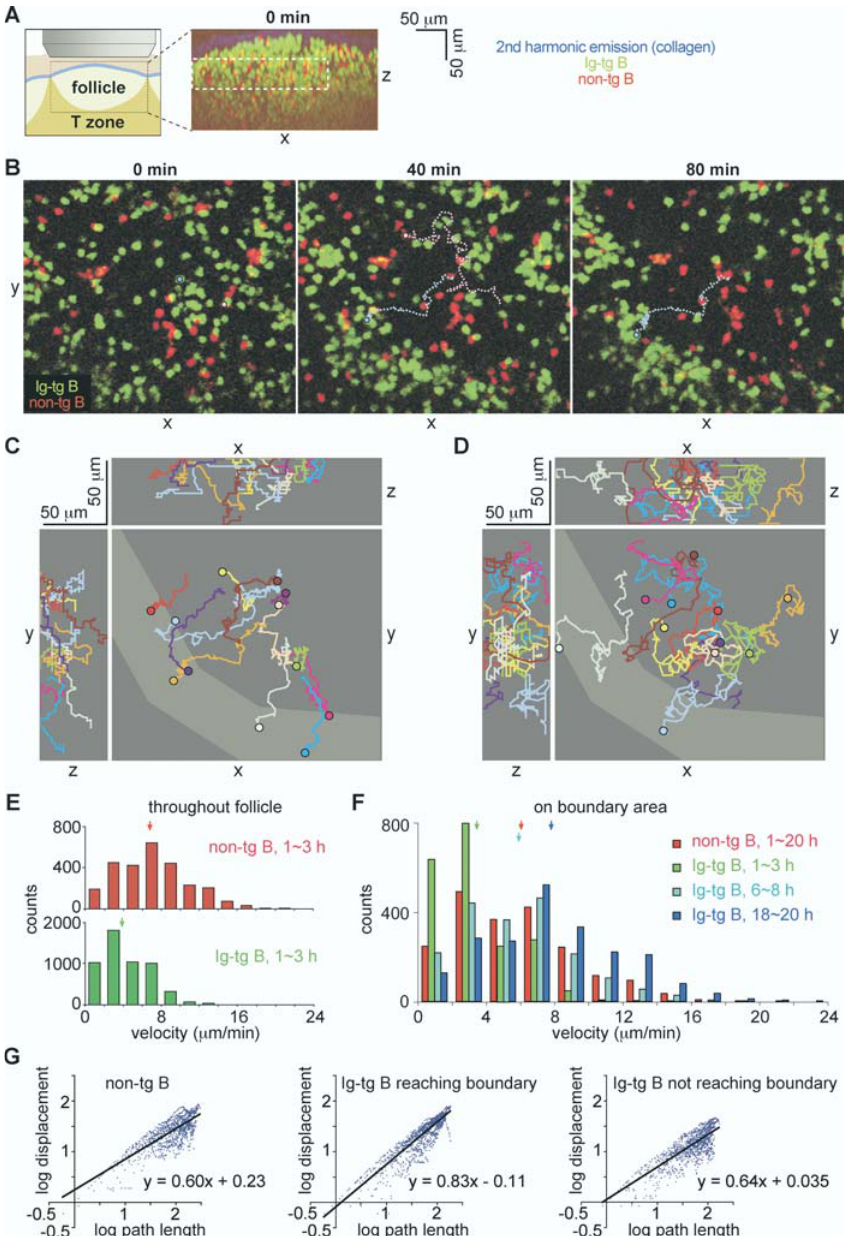
Figure 1. Antigen-Engaged B Cells Reduce Random Motility and Migrate Toward the Follicle–T Zone Boundary (A) On the left is a diagram showing the region of the inguinal lymph node that was imaged. The right panel shows the xz projection view of an image stack collected immediately prior to time-lapse imaging, demonstrating the location of a B cell follicle containing transferred B cells (green and red). The collagen-rich lymph node capsule is visualized by second harmonic emission (blue). The dashed white rectangle shows the region used in the time-lapse image analysis. (B) Time-lapse images of HEL-engaged Ig-tg B cells (green) clustering at the follicle–T zone boundary and naive non-tg B cells (red) in the follicle. The 0-min image is approximately 1 h after antigen exposure (see Video S1). The pathways of an Ig-tg B cell (light blue circle and dotted line) and a non-tg B cell (pink circle and dotted line) are traced as examples. The traced non-tg B cell moved out of the imaging stack at the 57.5-min timepoint. Scale as in (C). (C and D) Tracks of antigen-engaged Ig-tg (C) and naive non-tg (D) B cells in the xy-, xz-, and yz -planes. The boundary as defined by the area of Ig- tg B cell accumulation at 120 min is shown in lighter gray. Tracks cover 30 to 112 min (C) and 30 to 57 min (D). Circles indicate the end point of tracking. (E) Velocity distribution for naive (upper histogram) and antigen-engaged (lower histogram) B cells. Data are shown for 44 Ig-tg cells and 31 non- tg cells. Medians are indicated by arrows. (F) Velocity distributions for non-tg B cells at 1–20 h (red, n = 25) or Ig-tg B cells at 1–3 h (green, n = 29), 6–8 h (light blue, n = 21), or 18–20 h (dark blue, n = 39) after antigen injection. The data are for cells imaged in the boundary regions. Medians are indicated by arrows. (G) Ratios of log (displacement) to log (path length) of naive B cells (20 cells), antigen-engaged B cells that moved to the boundary (22 cells), or antigen-engaged B cells that did not move to the boundary (22 cells). Points indicate data for individual cells collected at cumulative 30-sec time intervals. The formula for each regression line is indicated. The correlation coefficients, R 2 , were 0.63, 0.80, and 0.67, respectively. Data are from three experiments and are representative of 12 to ; 18 cells from each recording. DOI: 10.1371/journal.pbio.0030150.g001 PLoS Biology |